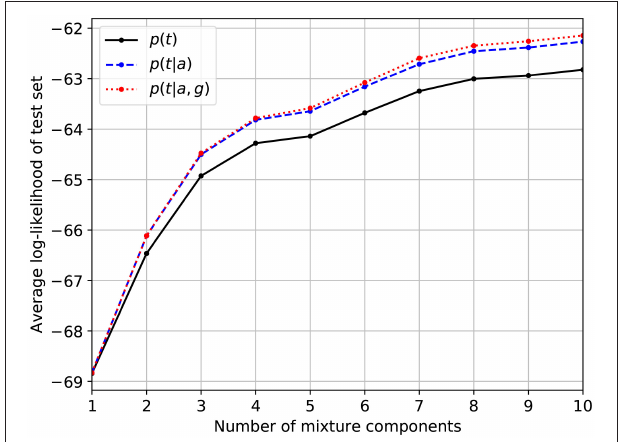
FIGURE 1 | Predictive accuracy of the optimized models as measured by the average log-likelihood of audiograms in the test set. The dashed and dotted lines denote the effect of conditioning the model on age ( a ) and/or gender ( g